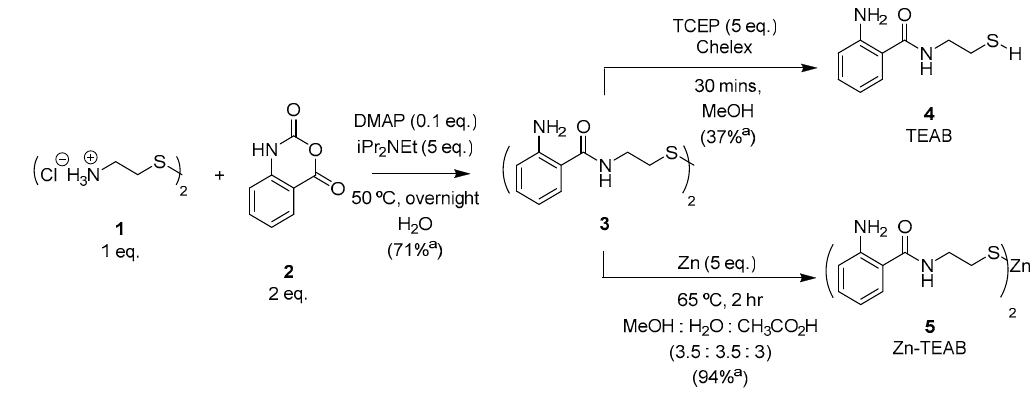
Figure 2. Synthesis of Zn-TEAB 5 . a Isolated yield.